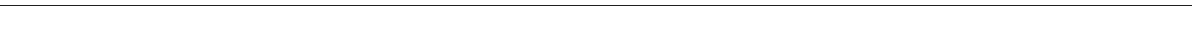
Fig. 1 FAP + HO-1 + TAMs in human and mouse breast adenocarcinoma are a tumour-educated phenotype. a , b Representative images of frozen human invasive ductal mammary carcinoma sections stained with DAPI (nuclei; blue) and antibodies against CD11b (green), FAP (yellow) and HO-1 (red) (representative images from n = 3 tumours). Arrows indicate cells co-expressing CD11b, FAP and HO-1. c , d Abundance ( c ) and surface characterisation ( d ) of live (7AAD − ) CD45 + F4/80 + TAMs from enzyme-dispersed 4T1 tumours (at day 24 post inoculation) as assessed using fl ow cytometry. Each point in c represents live F4/80 + cells in an individual tumour. Histograms represent positive staining for the markers shown (blue shaded) against that of the respective isotype controls (grey shaded). e Flow cytometry gating strategy for live CD11b + F4/80 low Ly6C hi monocytes in a representative enzyme- dispersed 4T1 tumour; histogram shows surface FAP staining (red shaded) against that of the isotype control (grey shaded). f Median fl uorescence intensity (MFI) of FAP surface expression with fl uorescence minus one (FMO) background staining subtracted on CD45 + F4/80 + TAMs from enzyme- dispersed 4T1 tumours on the indicated day post injection of the tumour cells ( n = 6). g , h Hmox1 mRNA expression relative to the housekeeping gene Tbp in 4T1 tumour tissue on the indicated day post inoculation of the tumour cells ( n = 6 – 8 tumours per time point) ( g ) and FACS-sorted monocytes, FAP lo F4/80 hi TAMs and FAP hi F4/80 hi TAMs and 4T1 tumour cells (CD45 − Thy1.2 − CD31 − ) from duplicate wells from a 4T1 tumour, data representative of using fl ow cytometry. Histogram represents positive staining for FAP (black line) against isotype control staining (grey shaded). j Hmox1 mRNA expression relative to the housekeeping gene Tbp in FACS-sorted monocytes (CD11b + F4/80 lo Ly6C hi ) and TAMs (F4/80 hi ) from duplicate wells from an E0771 tumour, data representative of duplicate experiments. k , l 4T1 (blue) and E0771 (black open) tumours were grown concurrently in opposing mammary fat pads in Rag2 − / − mice. k Schematic representation of the experimental setting (top) and representative FAP expression as assessed using fl ow cytometry on live CD45 + F4/80 hi TAMs from enzyme-dispersed tumours (bottom). l Hmox1 mRNA expression relative to the housekeeping gene Tbp in MACS- sorted TAMs from enzyme-dispersed tumours ( n = 4). Bar charts represent mean + s.d. * P <